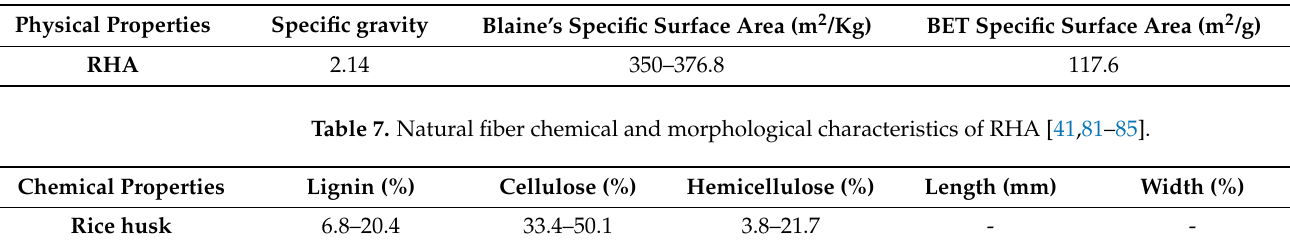
Table 6. Physical properties of RHA [3,78–80].